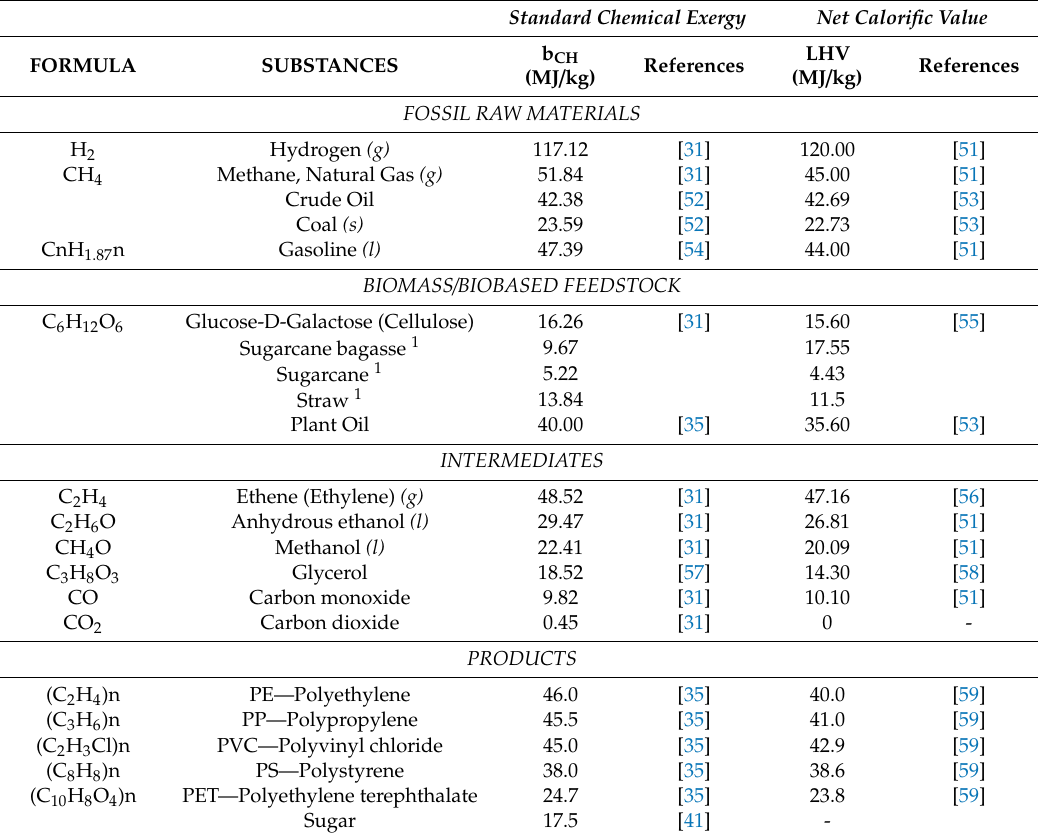
Table A13. Values of b ch and LHV for diverse compounds.